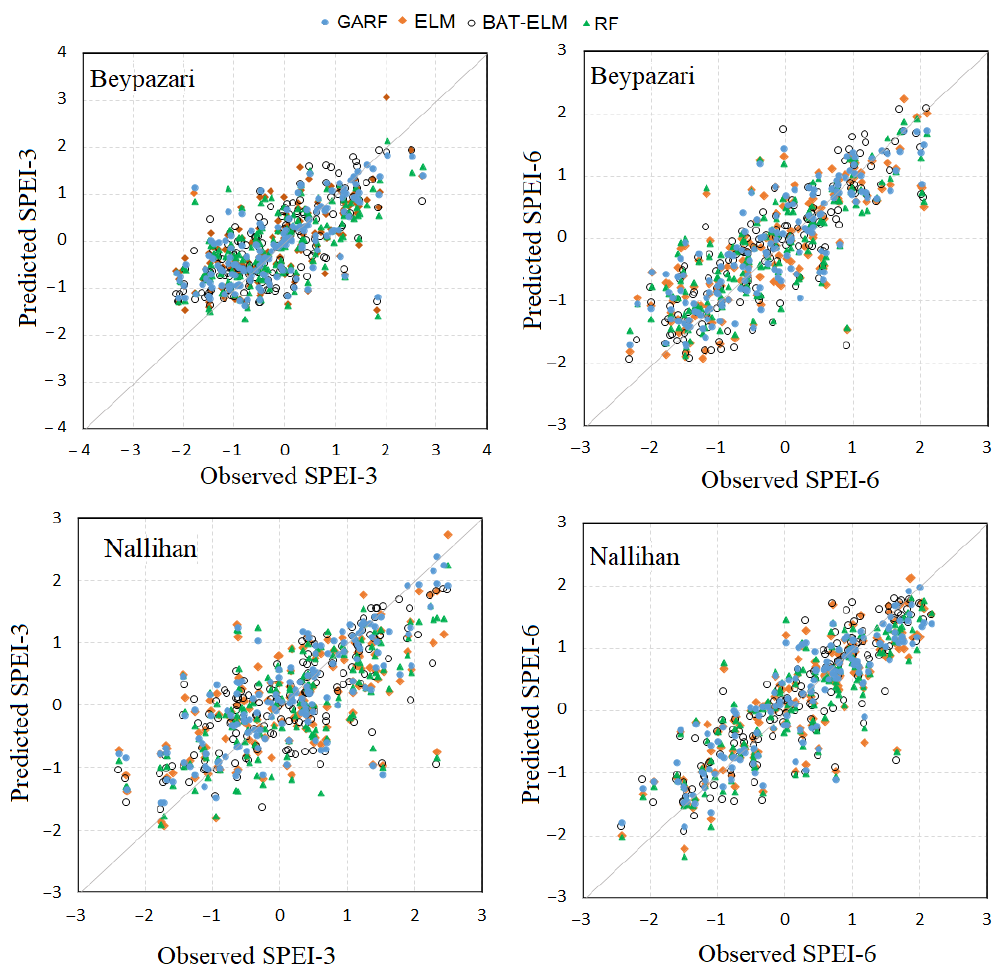
Figure 3. The scatter plots of evolved ML models for SPEI-3 and SPEI-6 forecasting at the meteorology stations.